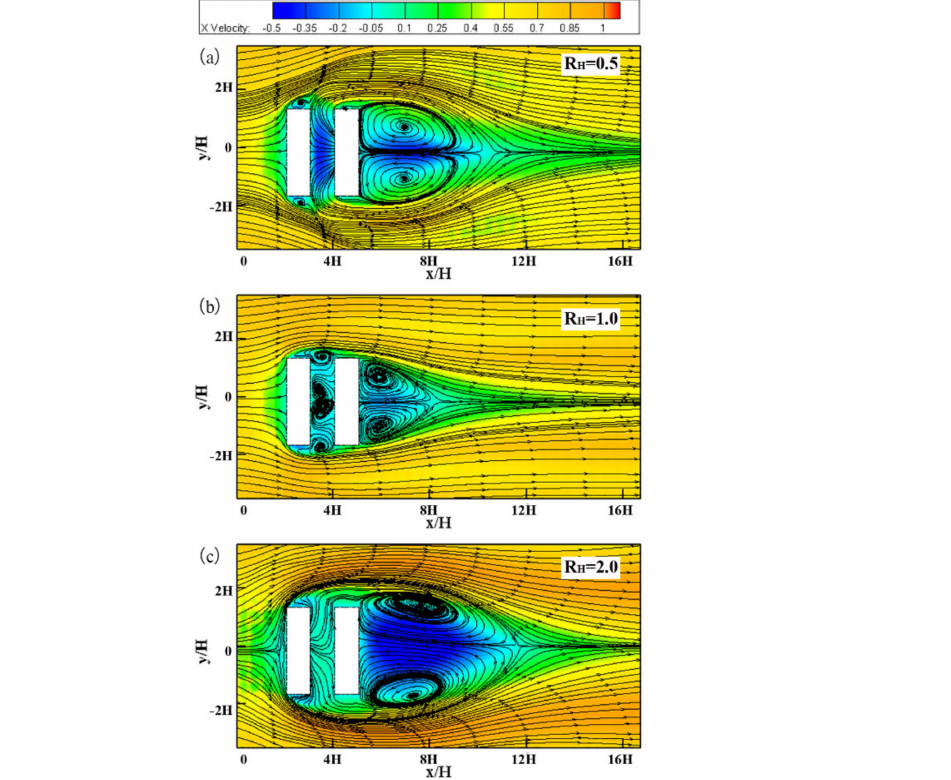
Figure 15. Time-averaged streamlines and flow velocity contours on the horizontal plane (z/H = 0.5) of streets with different height ratios: ( a ) R H = 0.5; ( b ) R H = 1.0; ( c ) R H = 2.0.